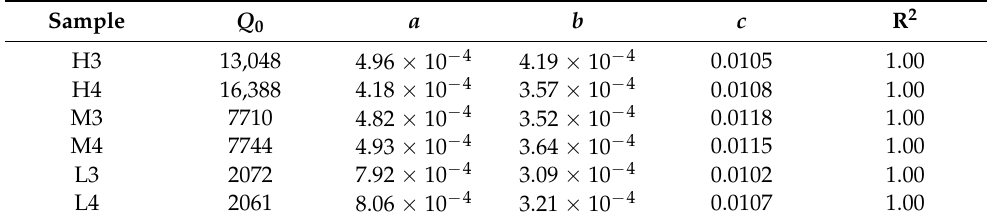
Table 7. Parameter values of Q-factor degradation fitting curve baking at 105 ◦ C.